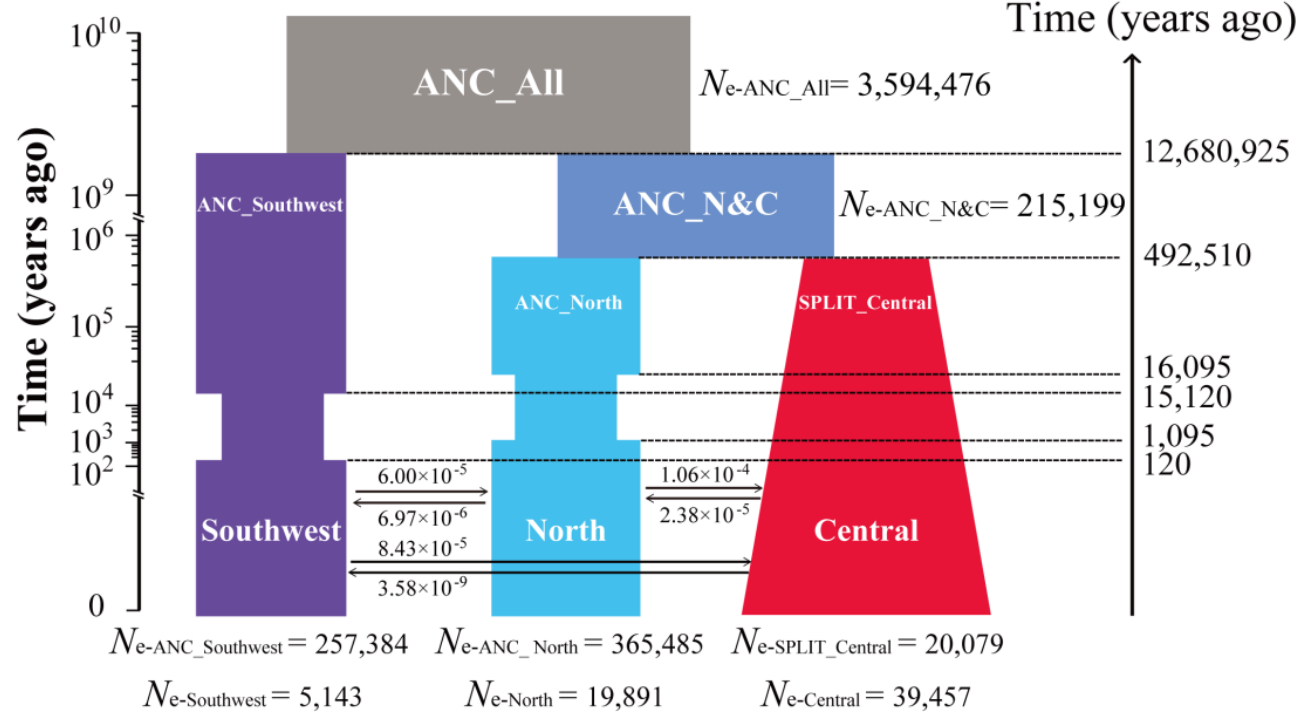
Figure 2. Demographic history of P. davidiana . A simplified graphic for the best supported model inferred by fastsimcoal2.6 . The N e represents the effective population size. The ancestral population (ANC_All) of three populations is colored gray, the ancestral population of the north and central populations (ANC_N&C) is colored gray-blue, and the north, central, and southwest populations are colored blue, red, and purple, respectively. The widths represent the relative N e . Double-headed arrows represent the per-generation gene flow between pairs of the three populations. All estimations of demographic parameters are shown in Table 1. The neutral mutation rate of each generation ( µ ) and the generation time was 3.75 × 10 − 8 per site per generation and 15 years in Populus , respectively.